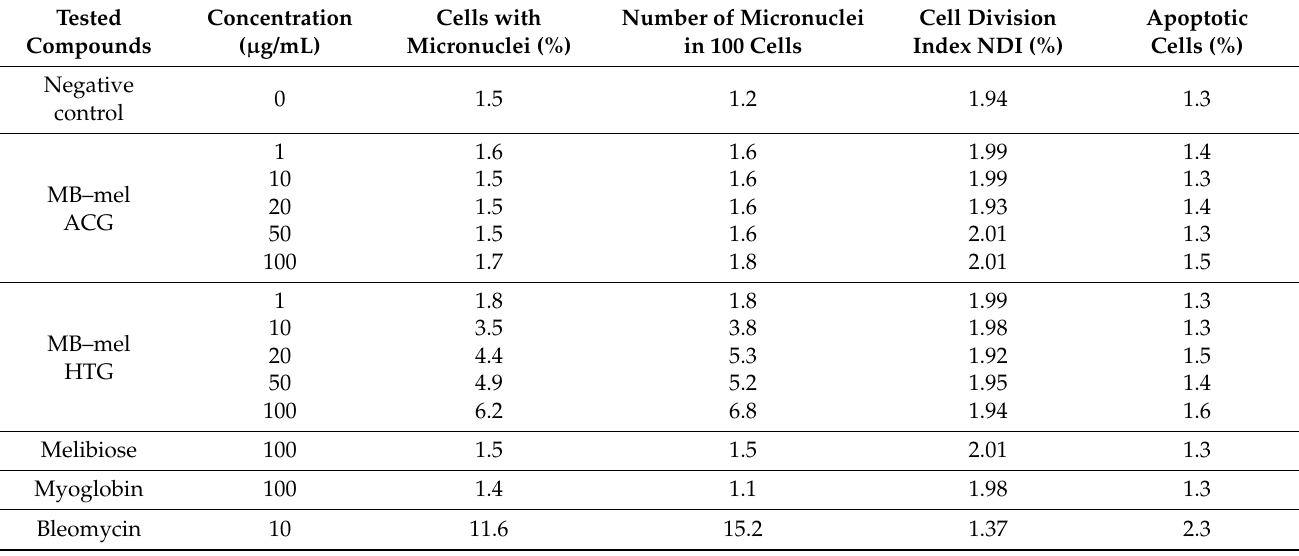
Table 6. The effect of advanced glycation end-products on HCT 116 (-/-) cells.